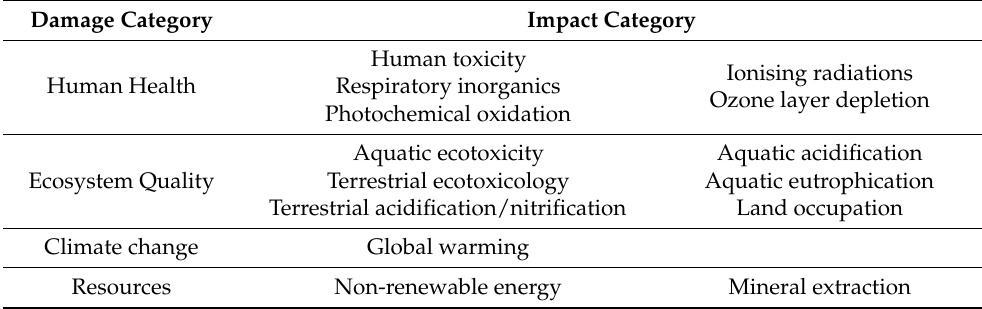
Table 5. Distinction between damage and impact categories [30]. Reprinted from [30], with the permission of AIP